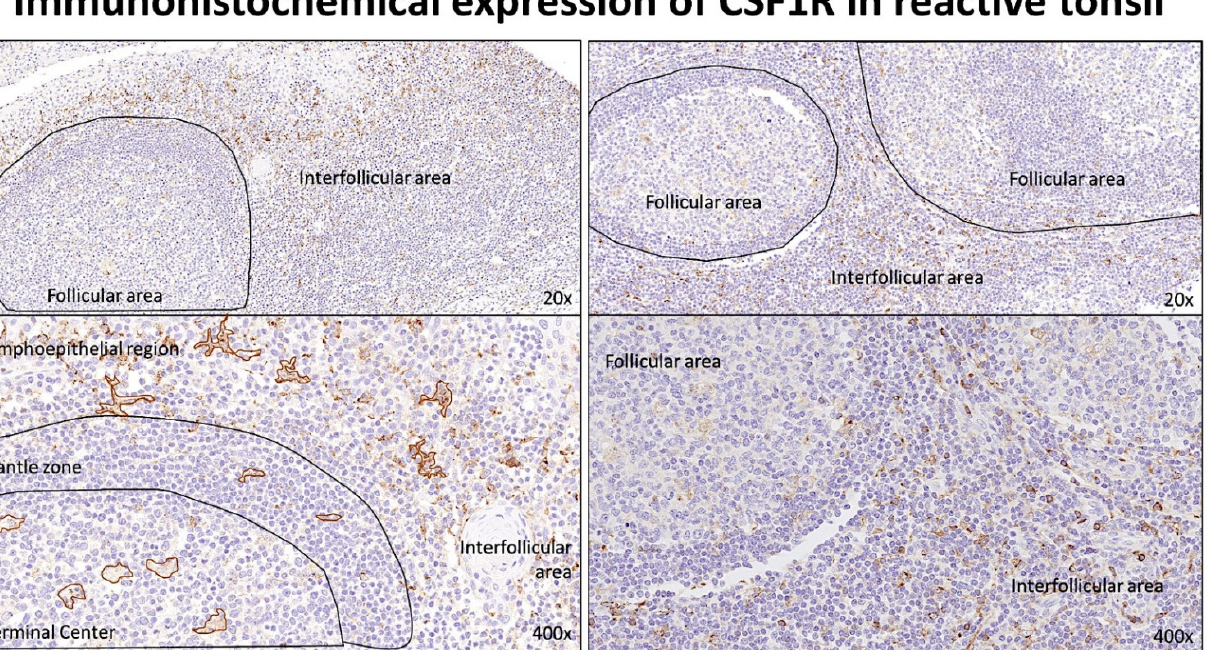
Figure 1. Immunohistochemical expression of CSF1R in reactive tonsils. The CSF1R expression was characteristic of macrophages. Their distribution was mainly interfollicular. In the germinal centers, a weak expression could be found in the tangible body macrophages. The B-lymphocytes were negative for CSF1R.